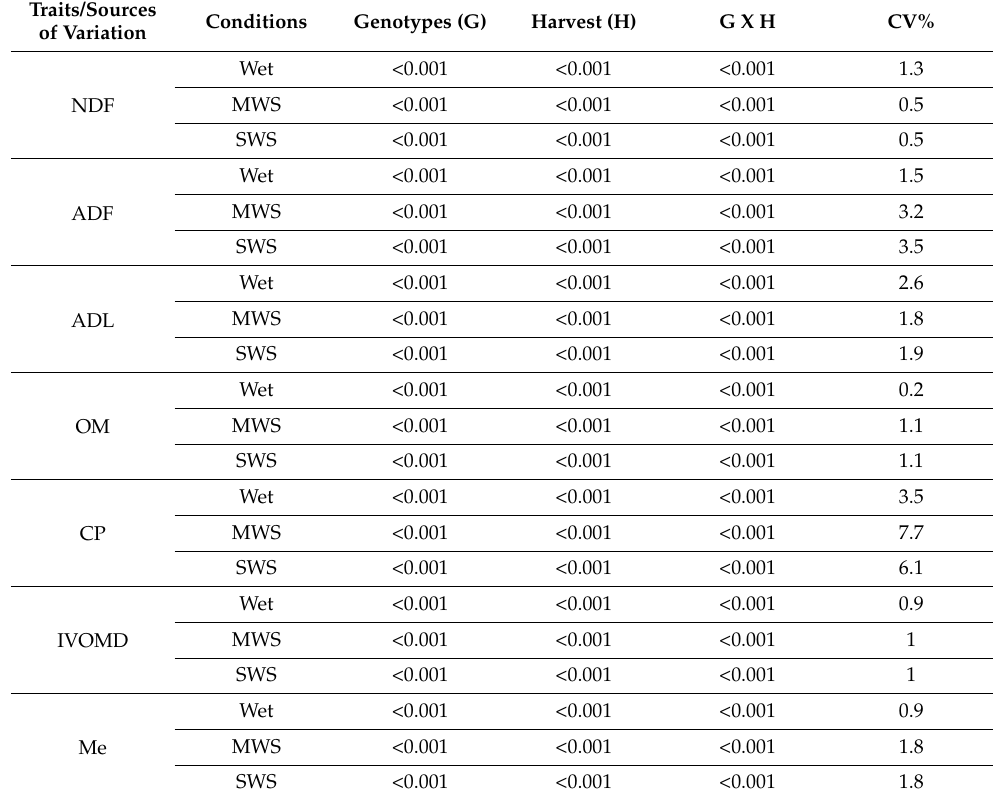
Table A6. ANOVA summary for seven feed quality traits of 84 Napier grass genotypes in wet, moderate water stress and severe water stress